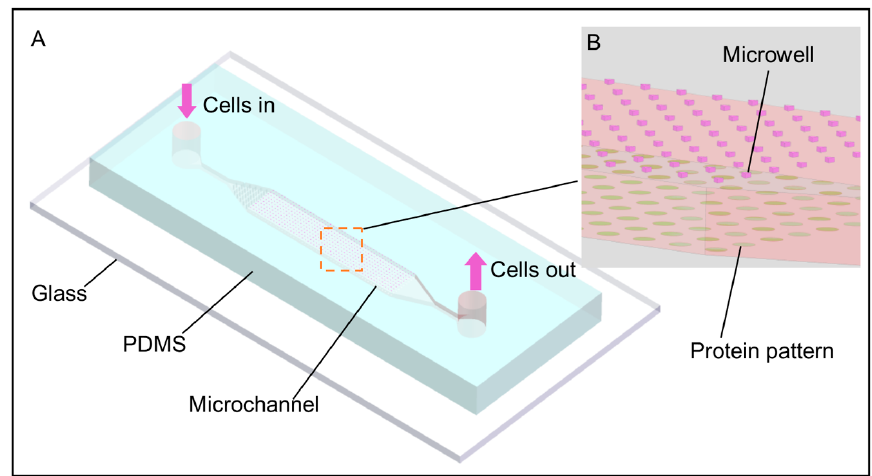
Figure 1. Schematic of the microfluidic chip with protein patterns paired with triangular microwells. Not to scale. Cells are captured within the microwells in the first step while these wells are flipped onto the floor. After flipping again, captured cells leave from the microwells and fall onto the corresponding protein patterns under gravity. Both the inlet and outlet are sealed before the second flipping to minimize possible perturbations of flow inside the channel. ( A ) Schematic of the whole chip; ( B ) a tilted, magnified view of the channel structure. The protein patterns (green colored) on the floor are precisely paired with the microwells (red colored) on the ceiling.